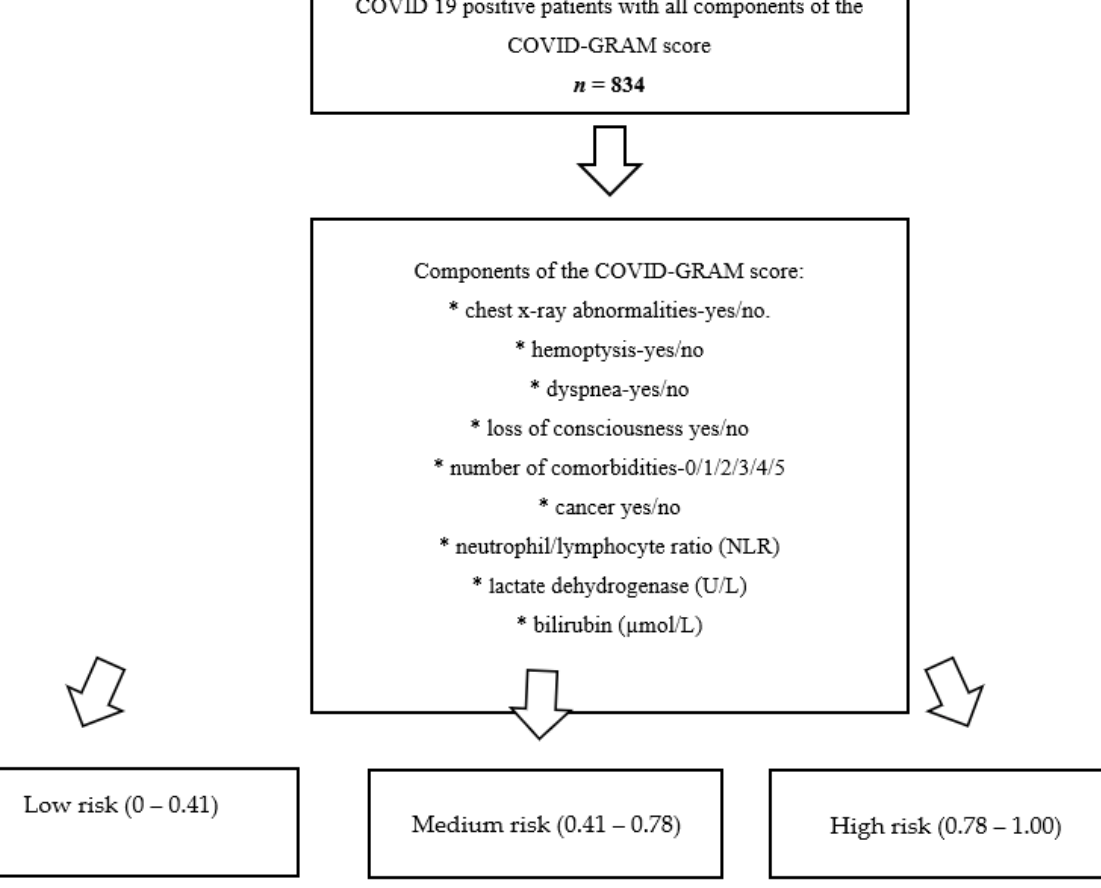
Figure 1. A flowchart of the study protocol presenting the subjects’ recruitment.